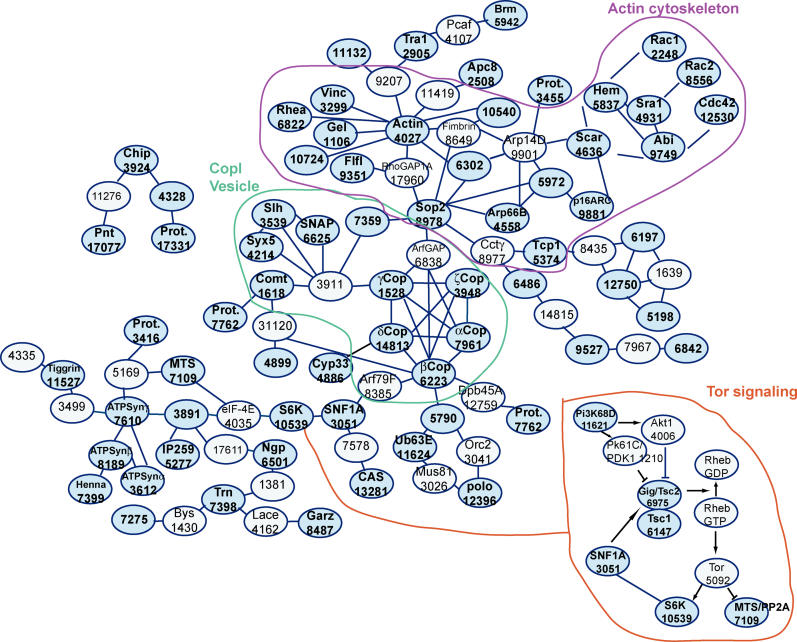
Genes Identified in the Screen as Being Required for Phagocytosis of C. albicans Were Superimposed onto a Drosophila Genomic Yeast Two-Hybrid Interaction MapInteractions are displayed, and several pathways are outlined. Dark-blue circles indicate genes identified as reduced phagocytosis of C. albicans, with light-blue circles indicating genes present in the two-hybrid map but not identified in the phagocytosis screen. Several functional groups are circled as indicated. This diagram represents only a portion of the complete two-hybrid map [35], indicating that the genes identified in the phagocytosis screen affect a limited number of cellular processes.